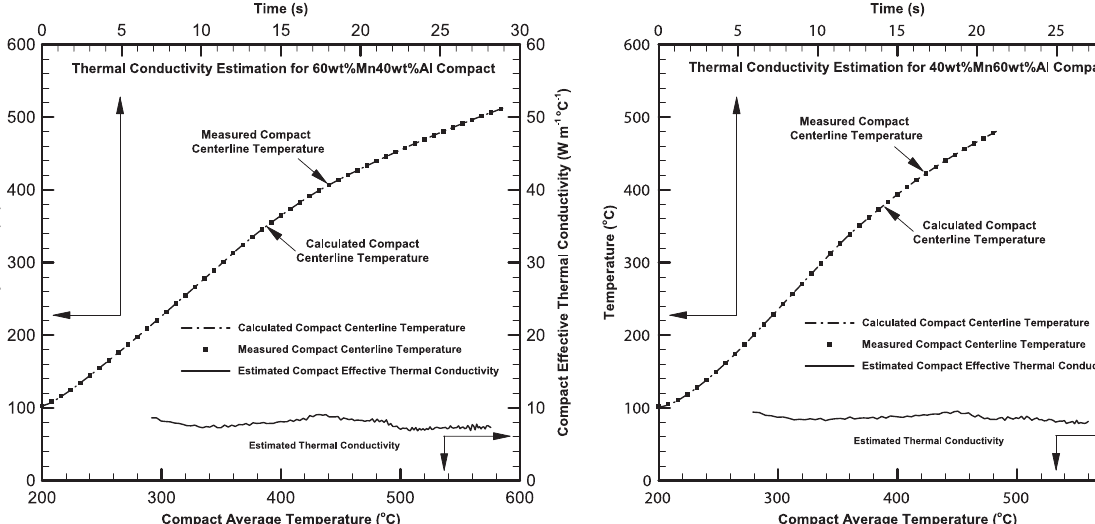
Fig. 13: Estimated Thermal Conductivity of a 60wt%Mn40wt%Al Compact